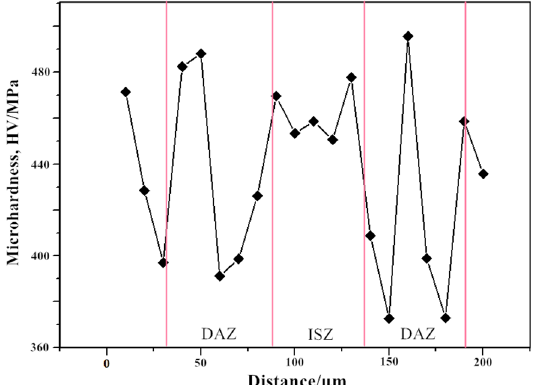
Figure 5. Microhardness variation between ISZ and DAZ. Table 2. Elements constituent of different regions (wt.%) Region